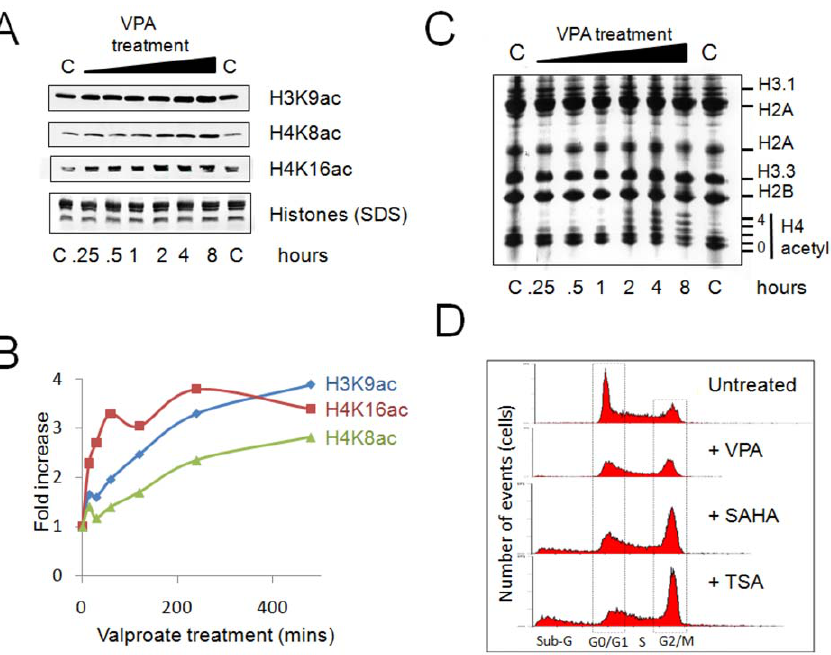
Figure 1. Changes in bulk histone acetylation and cell cycle progression induced by HDACi. ( A ) Western blots, and ( B ) quantification of the changes induced in H3K9ac, H4K8ac, H4K16ac abundance upon VPA treatment (5 mM, 8 hours). ( C ) Triton-acid-urea gel of histones isolated from control (C), or VPA–treated cells over the same time course. Histone H4 associated with none, one or more acetyl residues are indicated. ( D ) HDACi treatment impacts on the cell cycle. Fluorescence activated cell sorting of untreated and VPA (5 mM), SAHA (2.5 m M) or TSA (165 nM) treated cells (8 hours). Cells associated with distinct stages of the cell cycle are indicated. Cells labelled Sub-G are either dead or apoptotic.